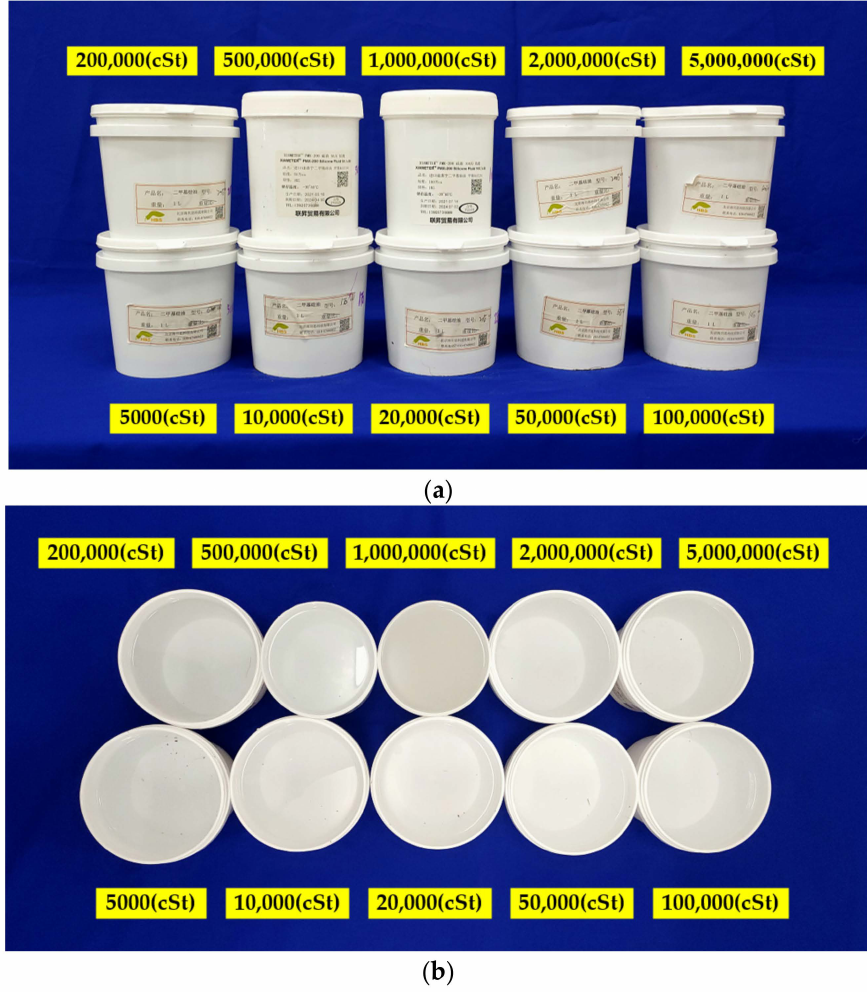
Figure 7. Photos of ten samples of damping fluids with different viscosities. ( a ) packages of damping fluid samples. ( b ) damping fluid samples inside packages.